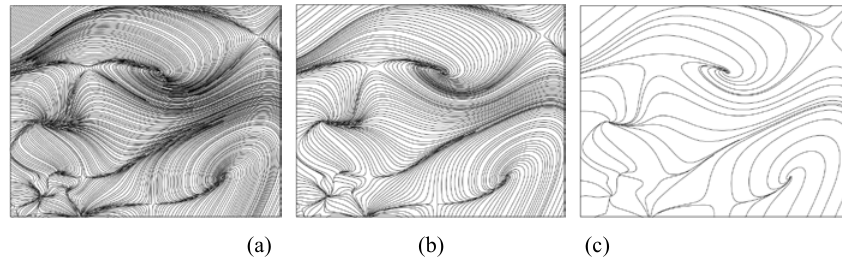
Fig. 4. Comparing the streamline diagrams changed by